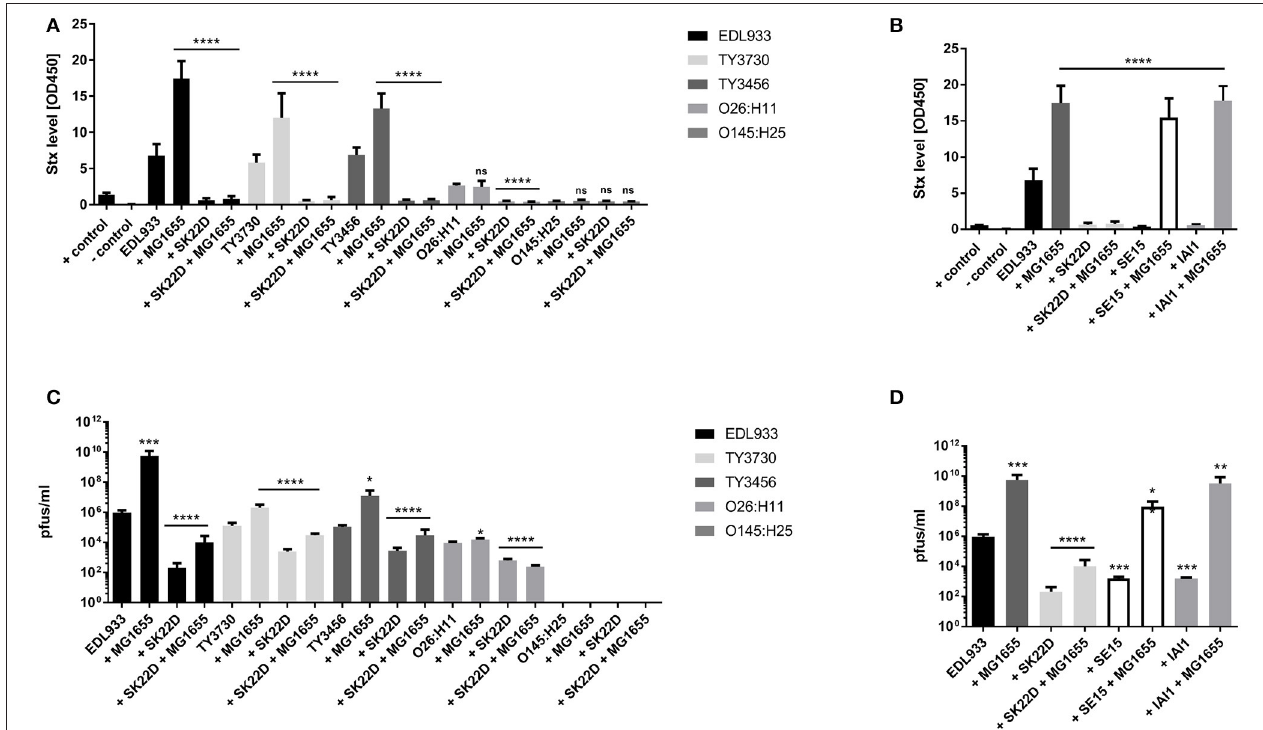
FIGURE 8 | Protection of MG1655 Stx2 STEC phage infection. The Stx2 STEC strains EDL933, the two isolates from 2011 TY3730 and TY3456, O26:H11 and O145:H25 were incubated in mono-/co-/ and tri-cultures with SK22D and/or MG1655 in a ratio of 1:10:10. Additionally, EDL933 was incubated in mono-/co-/ and tri-culture with the commensal strains SE15 and IAI1 and/or MG1655 (1:10:10). After a 24h, static incubation period the Stx level (A,B) and the phage titer (C,D) were detected in the sterile filtrate. The Stx level of the filtrate was determined with the Ridascreen ® Verotoxin Elisa. LB Medium was used as negative control. The phage titer was determined with the Phage Plaque Assay (PPA). ns, not significant, * p < 0.05, ** p < 0.01, *** p < 0.001, and **** p <